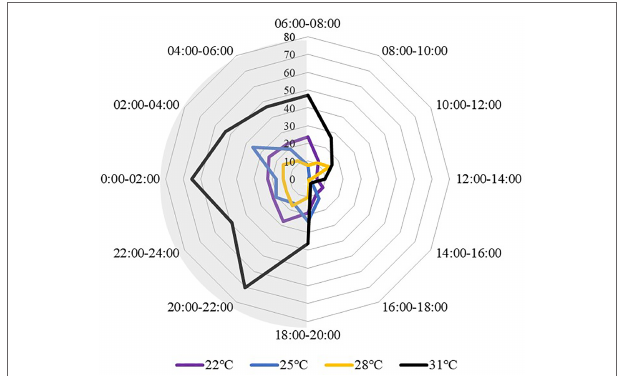
FIGURE 5 | Movement distance of S. monotuberculatus changed with time at four temperature conditions. Grey areas correspond to periods of night.